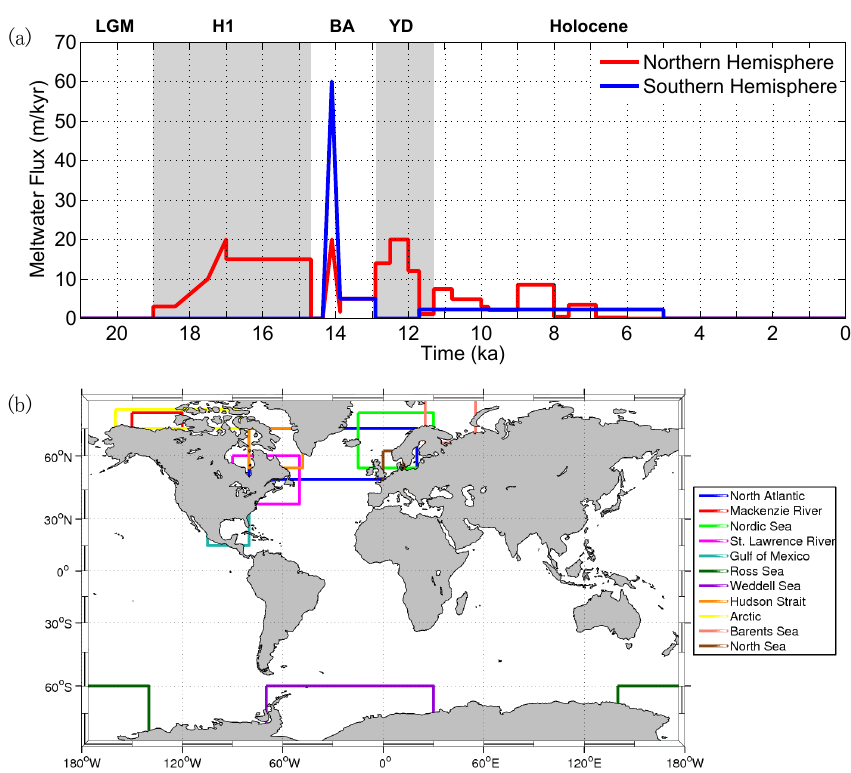
Figure 1. Meltwater discharges from the Northern (red line) and Southern (blue line) hemispheres (a) (1mkyr − 1 = 1m of equivalent global sea level rise per 1000 years = 0.0115Sv) (He, 2011). The main climatic events in the last deglaciation are also marked: Last Glacial Figure 1. (a) Meltwater discharges from the Northern (red line) and Southern (blue line) (cid:16096)(cid:16076) Maximum (LGM), Heinrich event 1 (H1), Bølling–Allerød (BA), Younger Dryas (YD) and Holocene. Locations where the meltwater was Hemisphere (1 m/kyr= 1 meter of equivalent global sea level rise per thousand year = 0.0115 (cid:16097)(cid:16076) injected into the TraCE-21K simulation (b) (adapted from He, Sv) (He, 2011). The main climatic events in the last deglaciation are also marked: Last Glacial (cid:16098)(cid:16076) Figure 1. (a) Meltwater discharges from the Northern (red line) and Southern (blue line) (cid:16096)(cid:16076) Maximum (LGM), Heinrich event 1 (H1), Bølling-Allerød (divided into 1, 2 and 3 stages, (cid:16099)(cid:16076) Hemisphere (1 m/kyr= 1 meter of equivalent global sea level rise per thousand year = 0.0115 (cid:16097)(cid:16076) where 2 states for MWP-1A), Younger Dryas (YD) and Holocene. (b) Locations where the (cid:16100)(cid:16076) Sv) (He, 2011). The main climatic events in the last deglaciation are also marked: Last Glacial (cid:16098)(cid:16076) meltwater was injected into the TraCE-21K simulation (adapted from He, 2011). (cid:16101)(cid:16076) Maximum (LGM), Heinrich event 1 (H1), Bølling-Allerød (divided into 1, 2 and 3 stages, (cid:16099)(cid:16076) where 2 states for MWP-1A), Younger Dryas (YD) and Holocene. (b) Locations where the (cid:16100)(cid:16076) meltwater was injected into the TraCE-21K simulation (adapted from He, 2011). (cid:16101)(cid:16076) (cid:16093)(cid:16092)(cid:16076) (cid:16093)(cid:16093)(cid:16076)